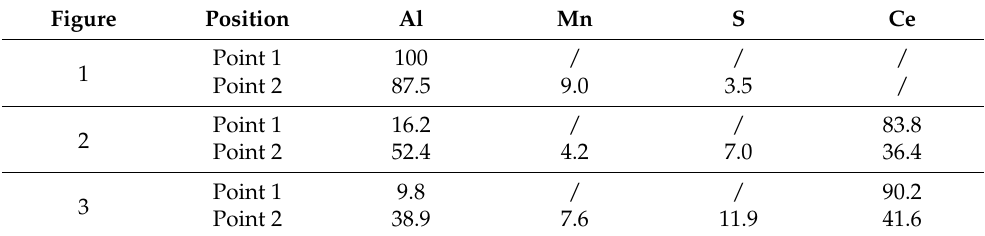
Table 2. EDS point analysis of typical oxides shown in the figures (mass percentage). Figure Position Al